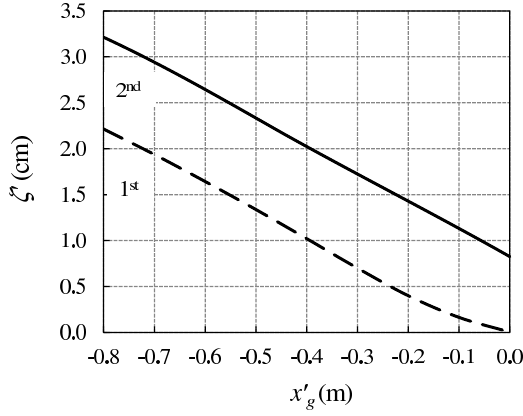
Fig. 7. Influence of the centroid initial position on the wave field. Figure shows the maximum free-surface elevation of the first wave (dashed line - -) and of the second wave (solid line − ) vs. x 0 g at a point on the shoreline ( y 0 = 3 . 10 m). Equation ( 39) is used to relate the slide velocity to the centroid initial position. The double Gaussian reference slide of parameters σ g = 0 . 37 m, η g = 0 . 045 m and c g = 2 (see Sect. 2.4) has been